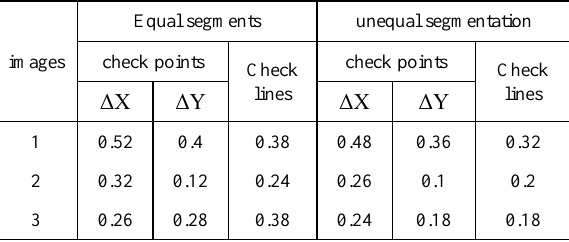
Table 3. Comparison of equal segments to unequal segments (Unit: